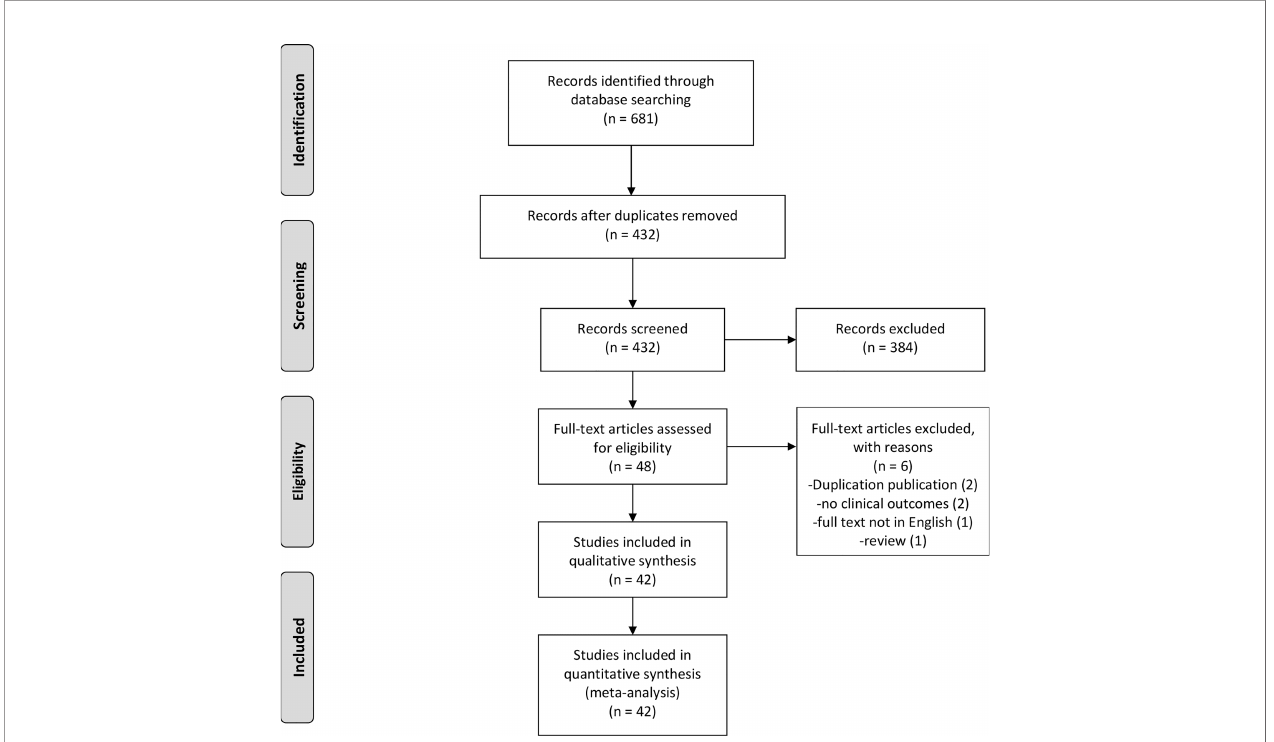
FIGURE 1 | The fl ow diagram of study